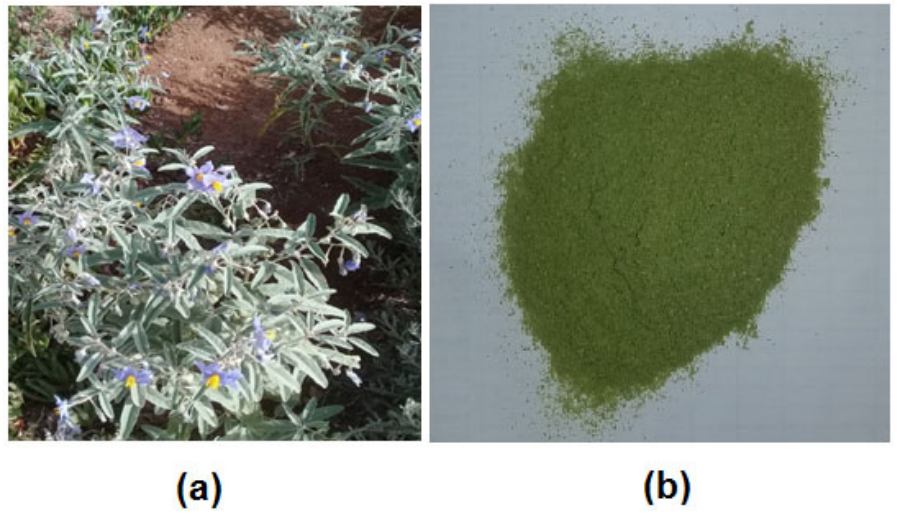
Figure 1. Plant of S. elaeagnifolium —( a ); powder of S. elaeagnifolium —( b